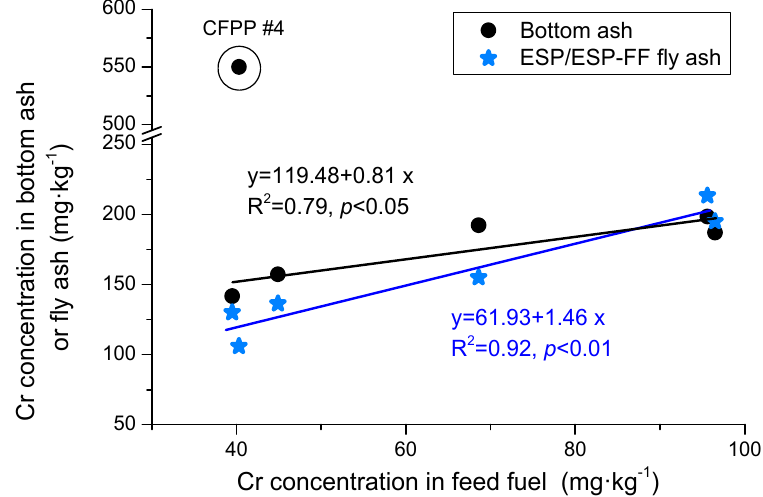
Figure 5. Pearson correlations between the Cr concentration in the feed fuel and bottom ash or the fly ash of the six CFPPs. Table 4. Relative enrichment index (REI) values of Cr in ESP/ESP–FF fly ash and bottom ash of the six CFPPs.